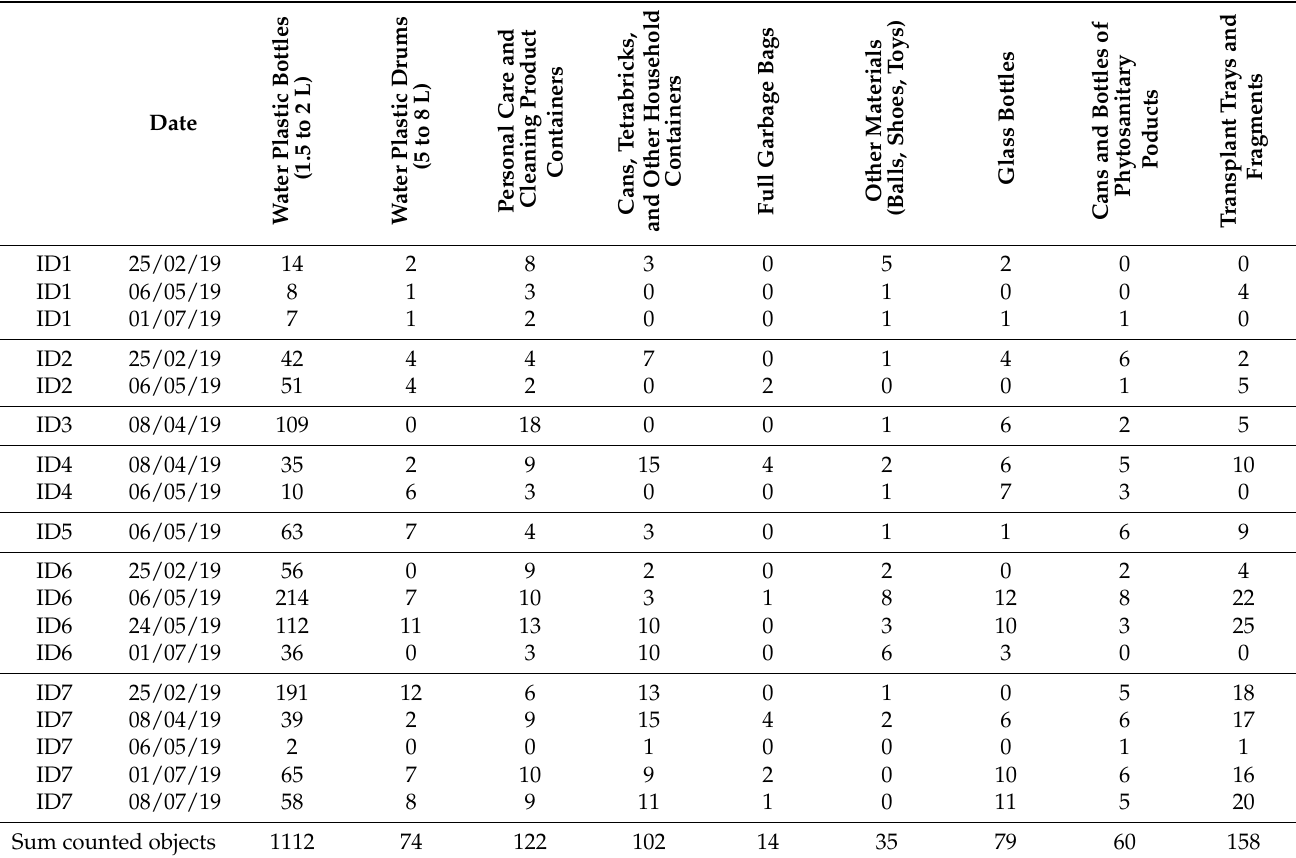
Table 5. Result of counting by image analysis of elements at different points and